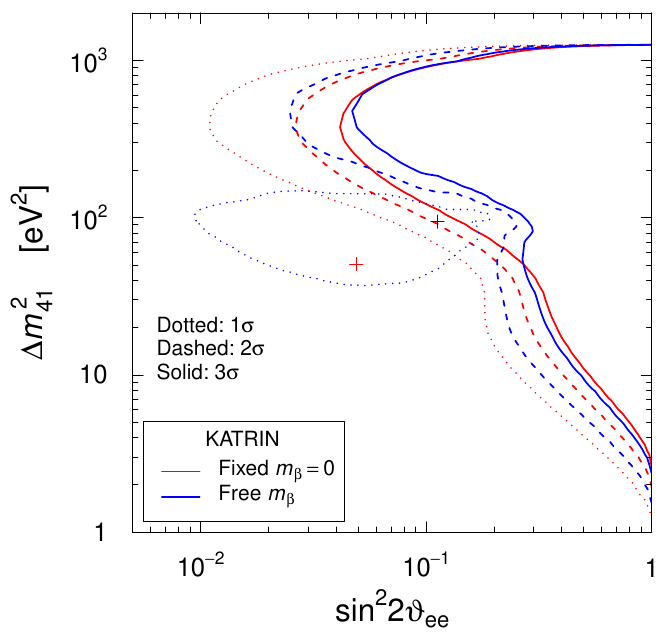
Figure 6. Contours delimiting the 1 σ , 2 σ , 3 σ allowed regions in the ( sin 2 2 ϑ ee , ∆ m 2 obtained from the analysis of KATRIN run 2 data. Red curves correspond to the analysis with fixed m β = 0 , while the blue curves are obtained after marginalizing over a free m β . The best-fit points are indicated by